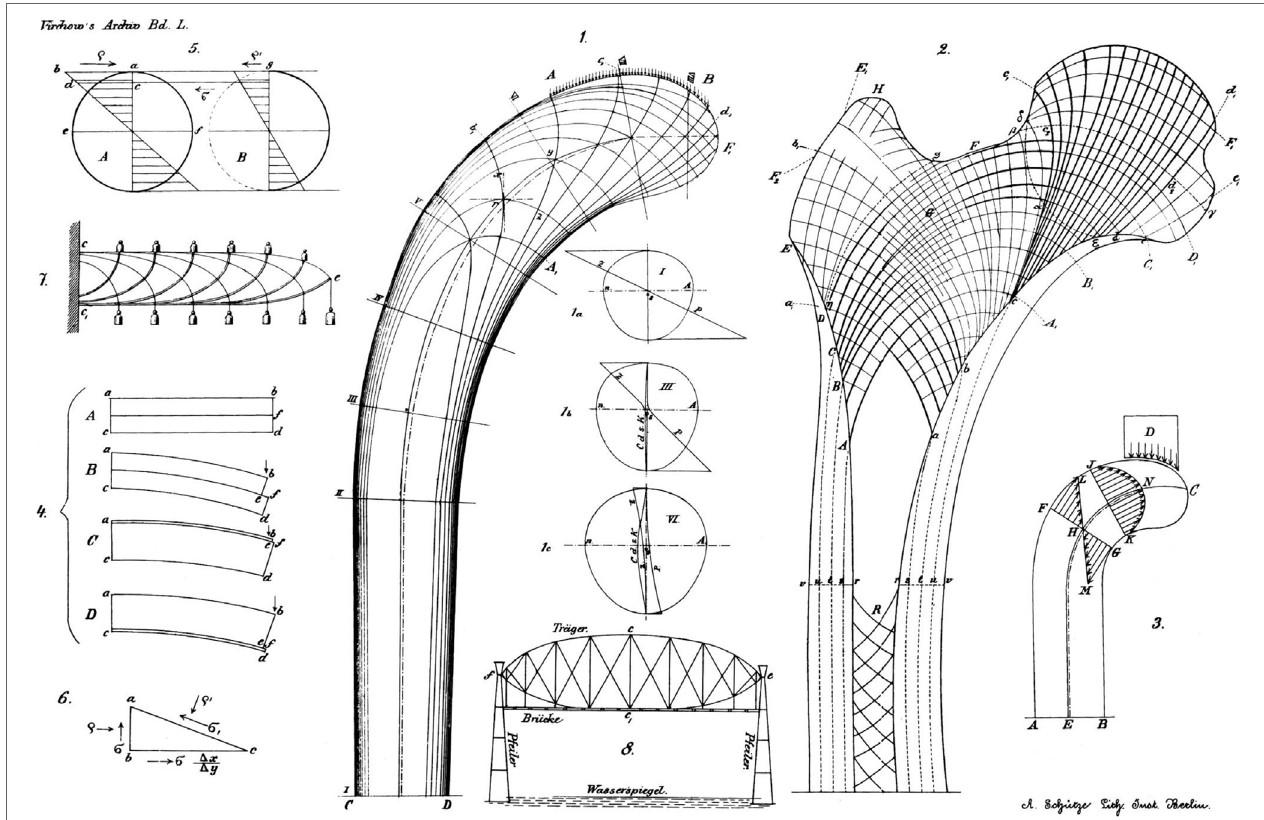
FigURe 1 | Stress lines in a crane as calculated and shown by Culmann (left) and the orientation of trabecular bone in a human femur as shown by Meyer (right) . Reprinted from Skedros and Brand (2011) with permission.